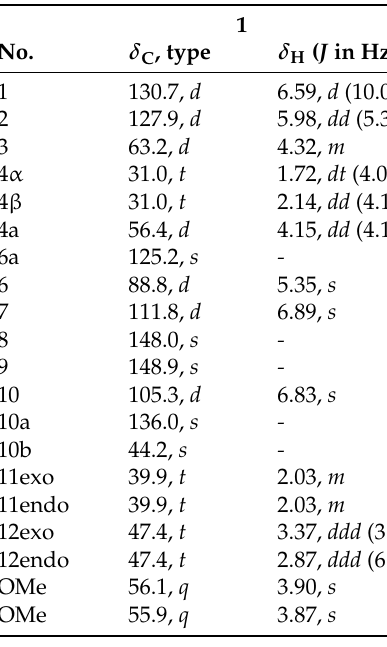
Table 2. NMR data for compounds 1 and 2 (500 MHz for 1 H and 125 Hz for 13 C, CDCl 3